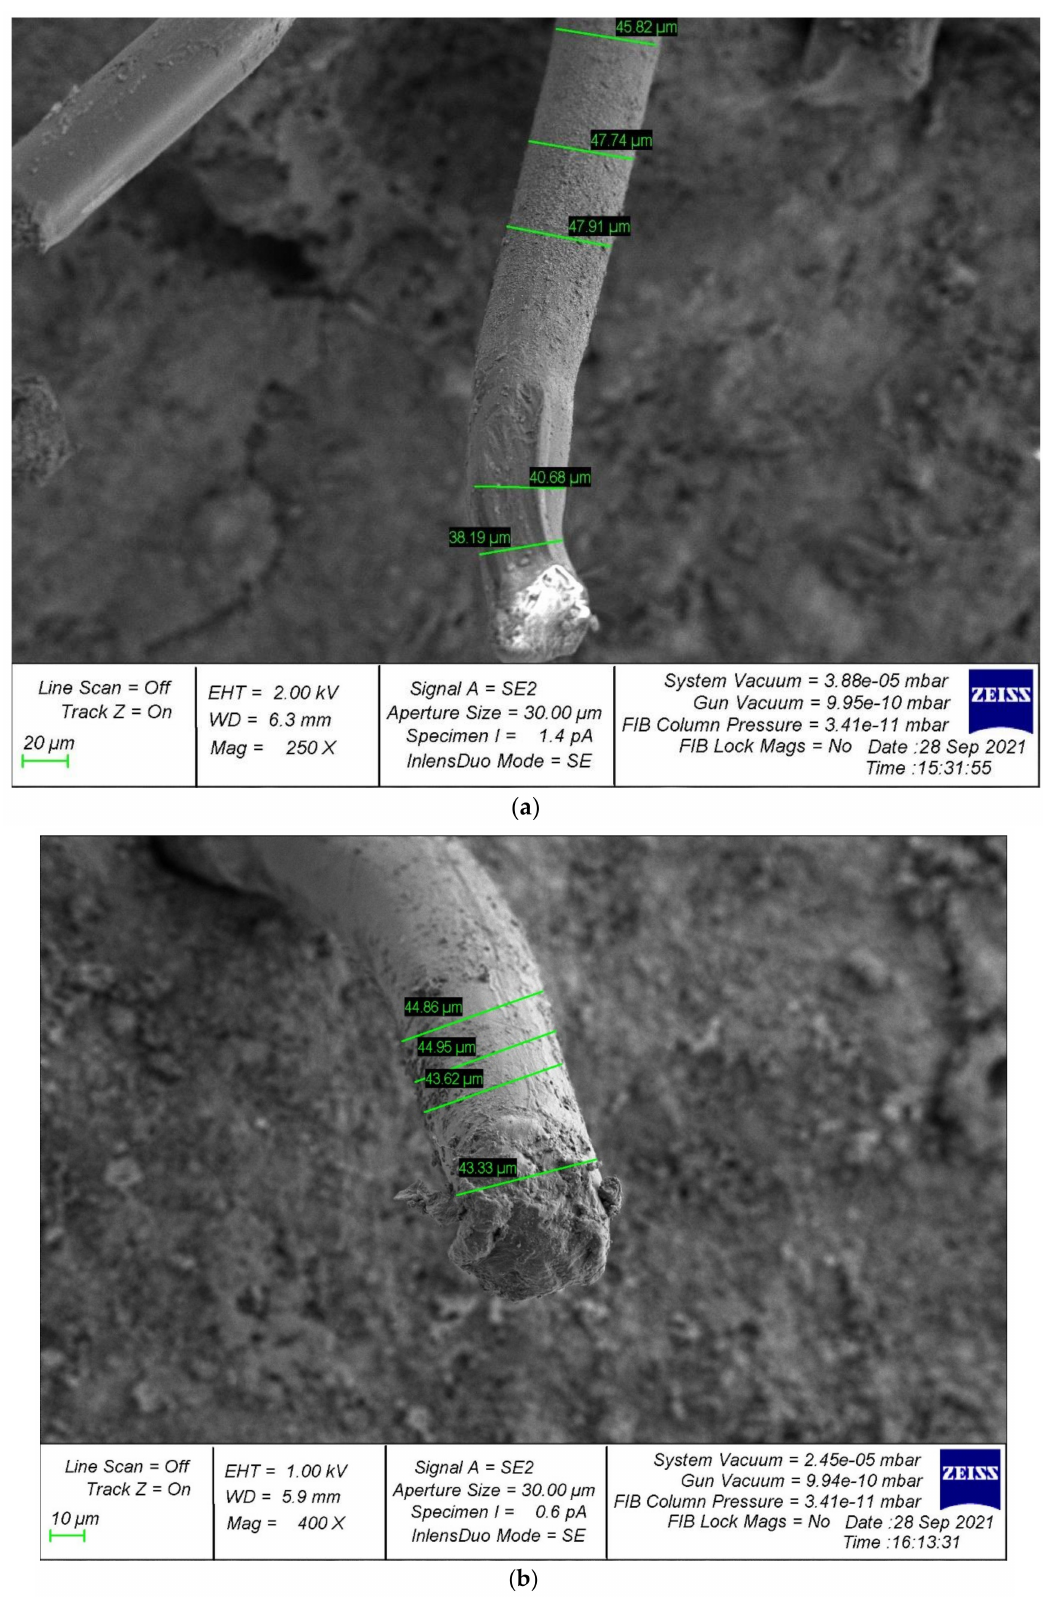
Figure 10. Analysis of the deformation of the fiber after fracture: ( a ) polydispersion-reinforced specimen; ( b ) monodispersion-reinforced